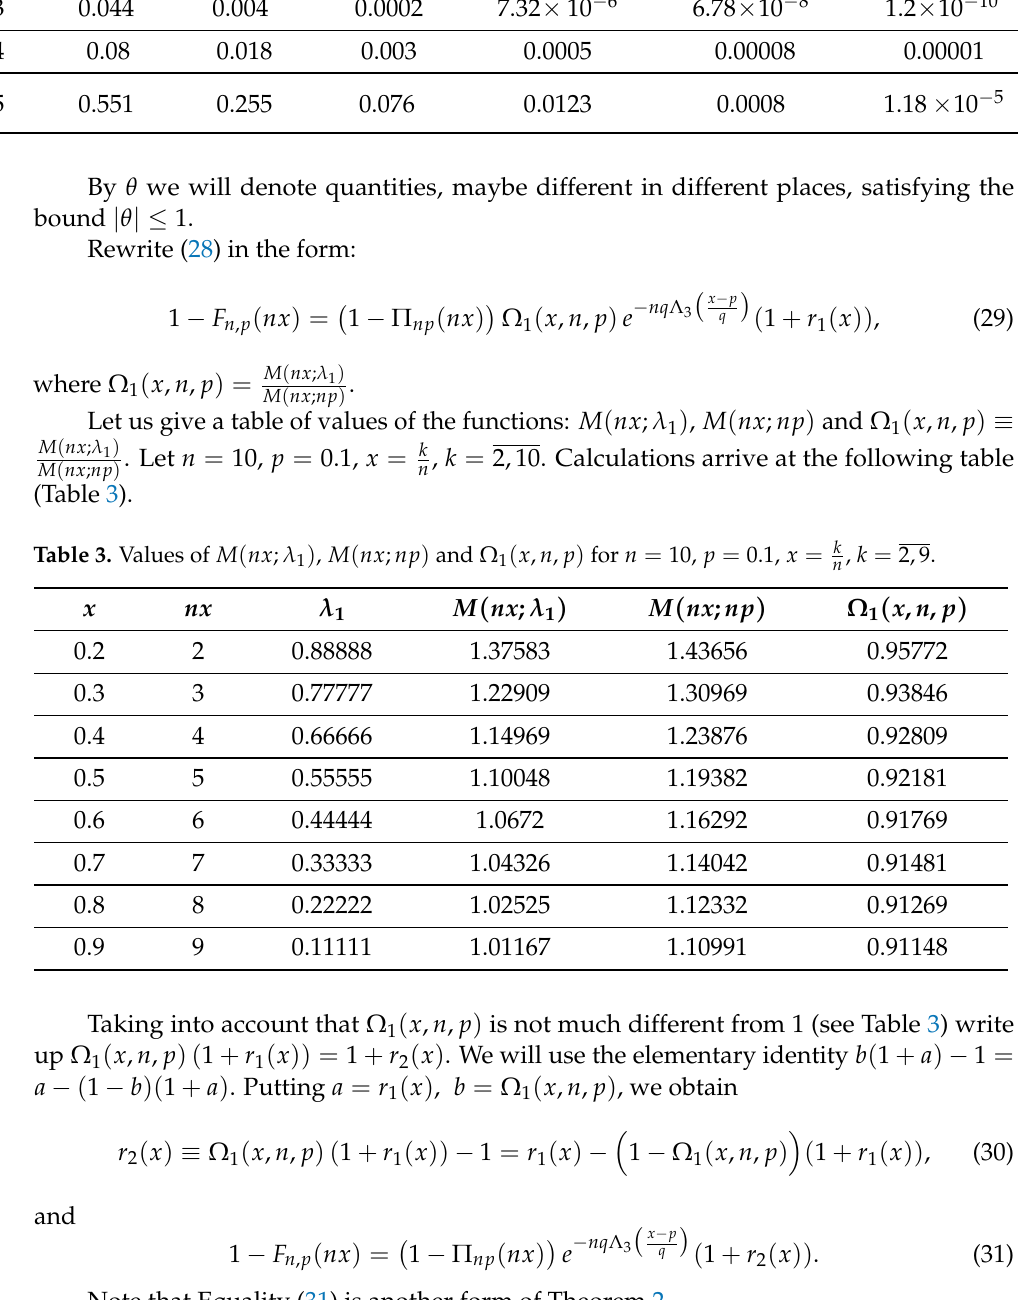
Table 2. Values of the ratio